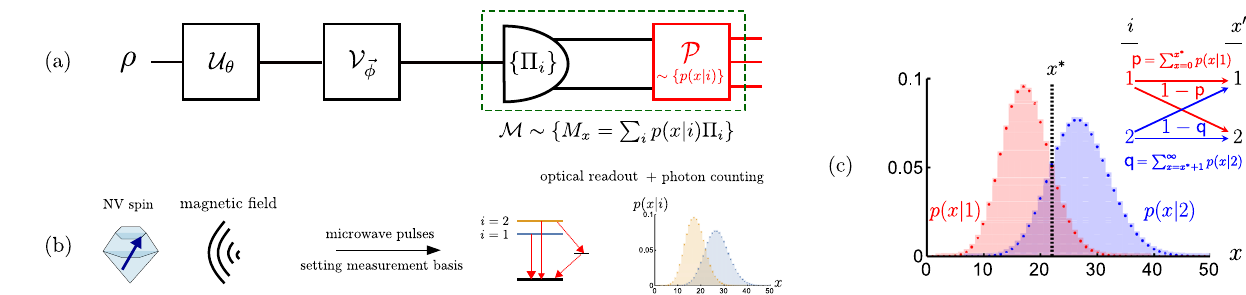
Fig. 1 | Imperfect measurements in quantum metrology. a Scheme of quantum metrology with an imperfectmeasurement. A quantum state ρ isfedinto a unitary channel U θ whichencodestheparameterofinterest, θ .Theprobeisthenrotatedby a unitary V ~ ϕ , so that a given projective measurement { Π i } can be performed in the preferred basis. The measurement M is, however, imperfect , i.e.,: different { i } outcomes are ‘ inaccessible ’ being mapped onto another set of ‘ observable ’ out- comes { x }, as speci fi ed by the noisy detection channel (stochastic map) P ∼ f p ð x ∣ i Þg . b Phase sensing with the nitrogen-vacancy (NV) centre used as a spin probe. The spin of the NV is initialised in an equal superposition between the m s =0,1 ( i =1,2) energy-level states and evolves in presence of an external magnetic fi eld, which